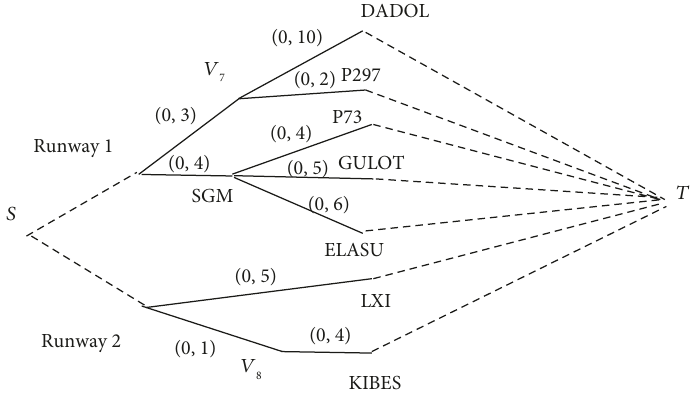
Figure 11: Arrival route network with capacity under the meteorological in fl uence